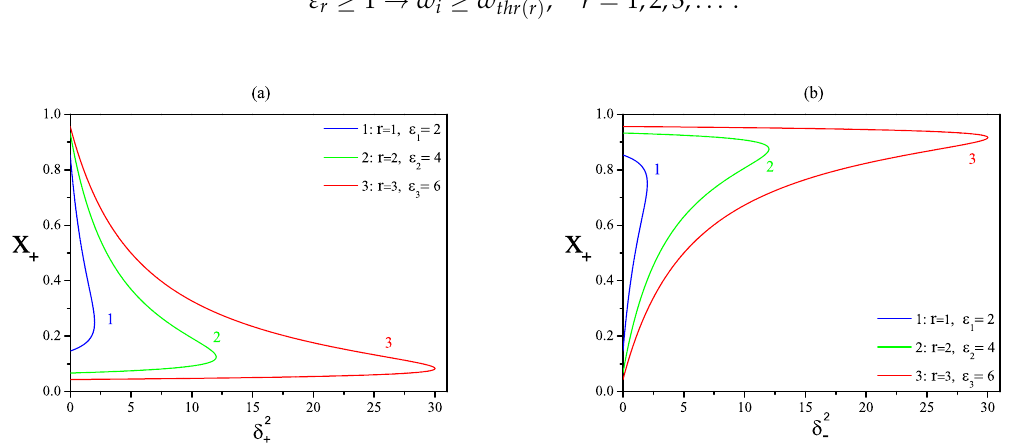
Figure 2. Dependence of the positron resonant energy on the parameter δ 2 + (27) (( a ), for the channel A) and on the parameter δ 2 − (28) (( b ), for the channel B) for the case ω i > ω thr ( 1 ) and the first three (cid:17) (cid:16) ω i = 500 MeV, ω thr ( 1 ) = 250 MeV resonances